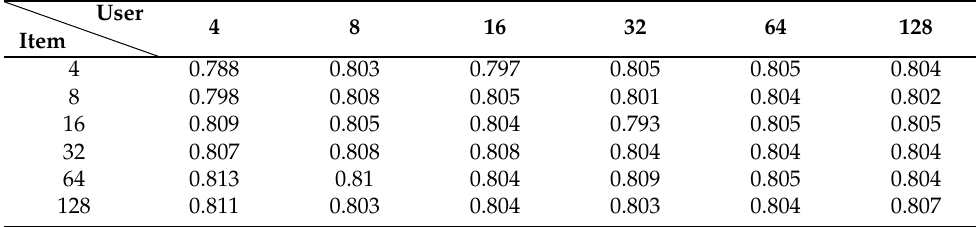
Table 5. The effect of size of triple set on F1 in Last.FM.